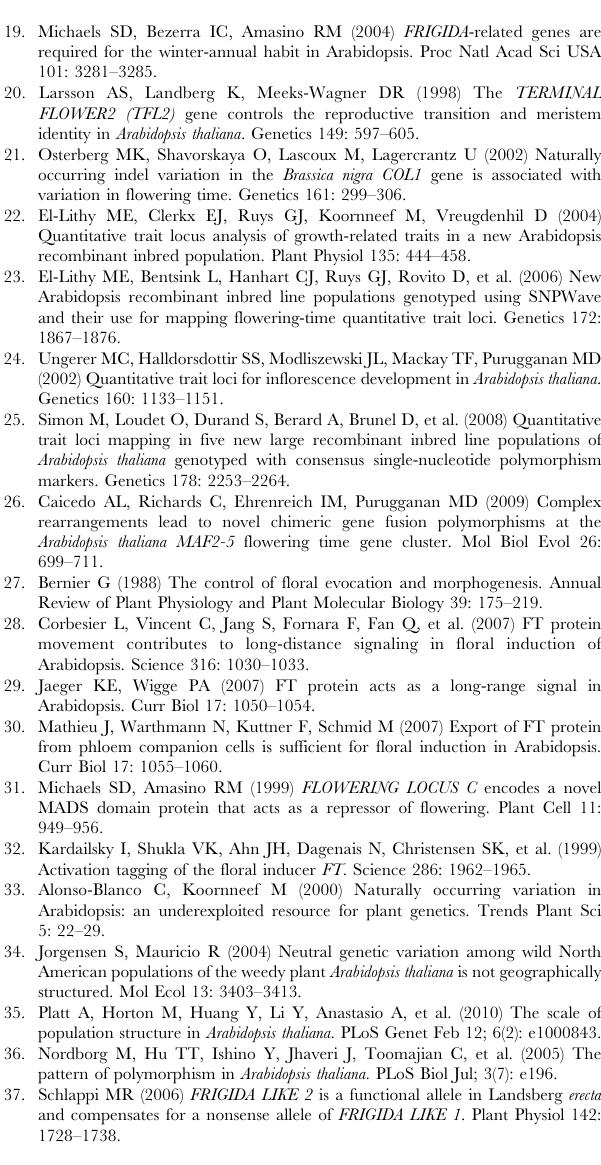
Figure S6 Flowering time of RRS-10 6 Col F2 population after 8 weeks vernalization grouped by genotype at marker underlying the QTL. (TIF) Figure S7 Polymorphisms within FLC genomic frag- ment of Kno-18 and RRS-10. (TIF) Figure S8 FLC TE490 transposon insertion in RRS-10 and Kno-18. (TIF) Table S1 Markers and their alternative names used to generate the genetic maps. (XLSX) Table S2 Primer sequences of mapping markers devel- oped in this study. (DOC)